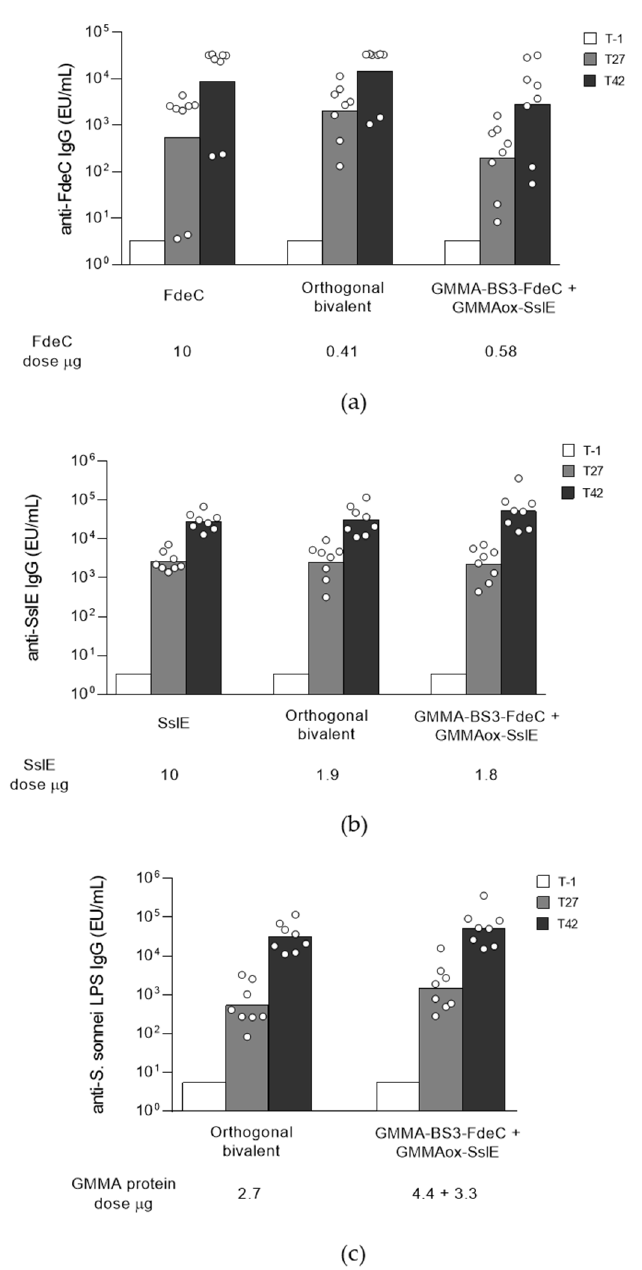
Figure 10. SslE and FdeC presented on the same S. sonnei GMMA particle compared to proteins alone and to the corresponding monovalent conjugates mixed together. CD1 mice were immunized intramuscularly at day 0 and 28, with 10 µ g E. coli protein/dose (group with proteins alone), 5 µ g total protein/dose (groups with conjugates). All constructs were formulated with 0.7 mg/mL Alhydrogel. Sera were collected at days − 1, 27 and 42 and analyzed by ELISA for anti- E. coli antigen-specific ( a , b ) and anti- S. sonnei LPS ( c ) IgG response. Summary graphs of anti-antigen specific IgG geometric mean units (bars) and individual antibody levels (dots) are reported.